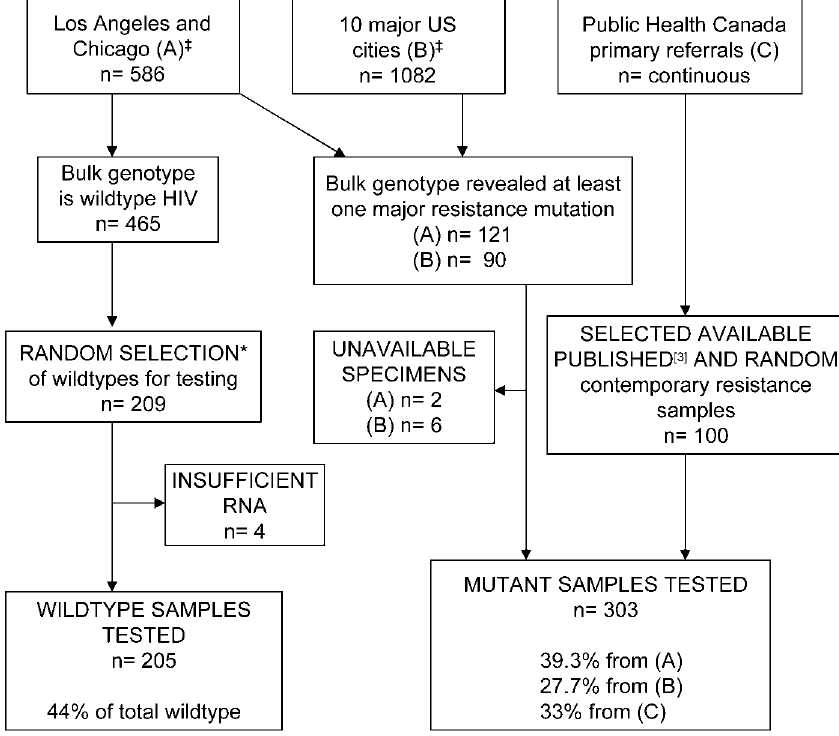
Figure 1. STROBE-Type Flow Diagram for the Retrospective Cross-Sectional (Newly Diagnosed Surveillance) Study Illustrating Drug Resistance in the Parent Cohorts and the Sample Selection for Real-Time PCR Resistance Testing Additional details are provided in Table 1.